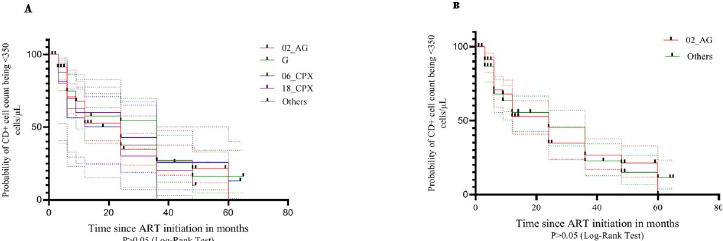
Fig 2. Kaplan_Meier analysis of time to reach CD4+ T_cell count of � 350 cells/ μ L on cART (A) Comparing the all subtypes. (B) Comparing subtypes G and CRF02_AG.